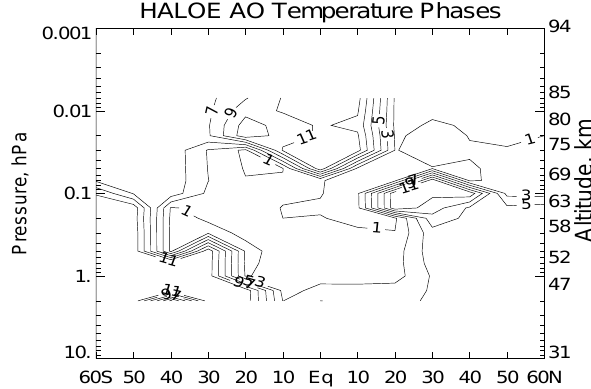
Fig. 4. Contour plot of the zonal average temperature phase (month of year) for the maximum of the first cycle of the semi-annual os- cillation (SAO) term. Contour interval is 1 month. Altitude scale is approximate.